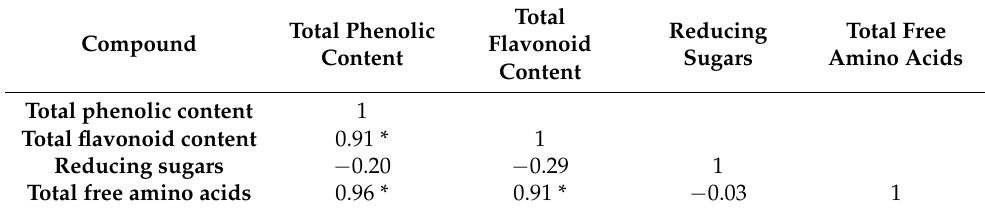
Table 4. Pearson correlation analysis of total phenolic content, total flavonoid content, reducing sugars and total free amino acids of three Centaurea species.